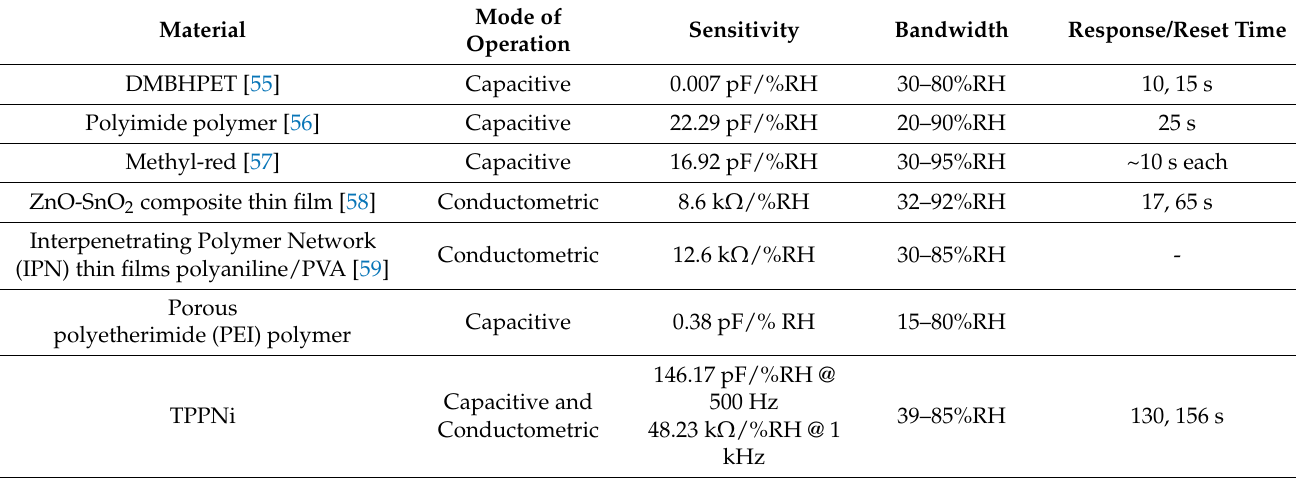
Table 2. Comparison of humidity sensors based on key performance parameters.